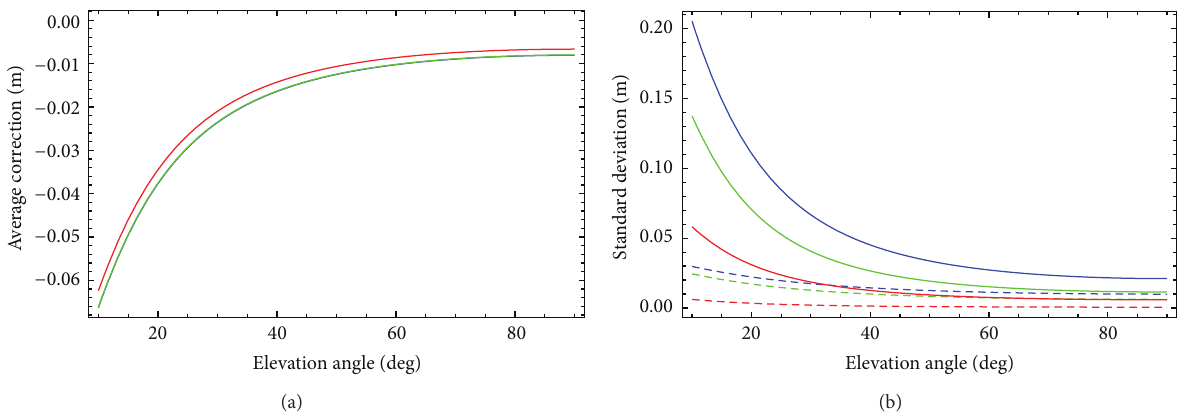
Figure 1: Elevation angle dependence of average (a) and standard deviations (b) of corrections of first (dashed line) and third (solid line) orders for ionosphere-free combination (4) at inner sizes of 50 m (blue line), 200 m (green line), and 1000 m (red line).